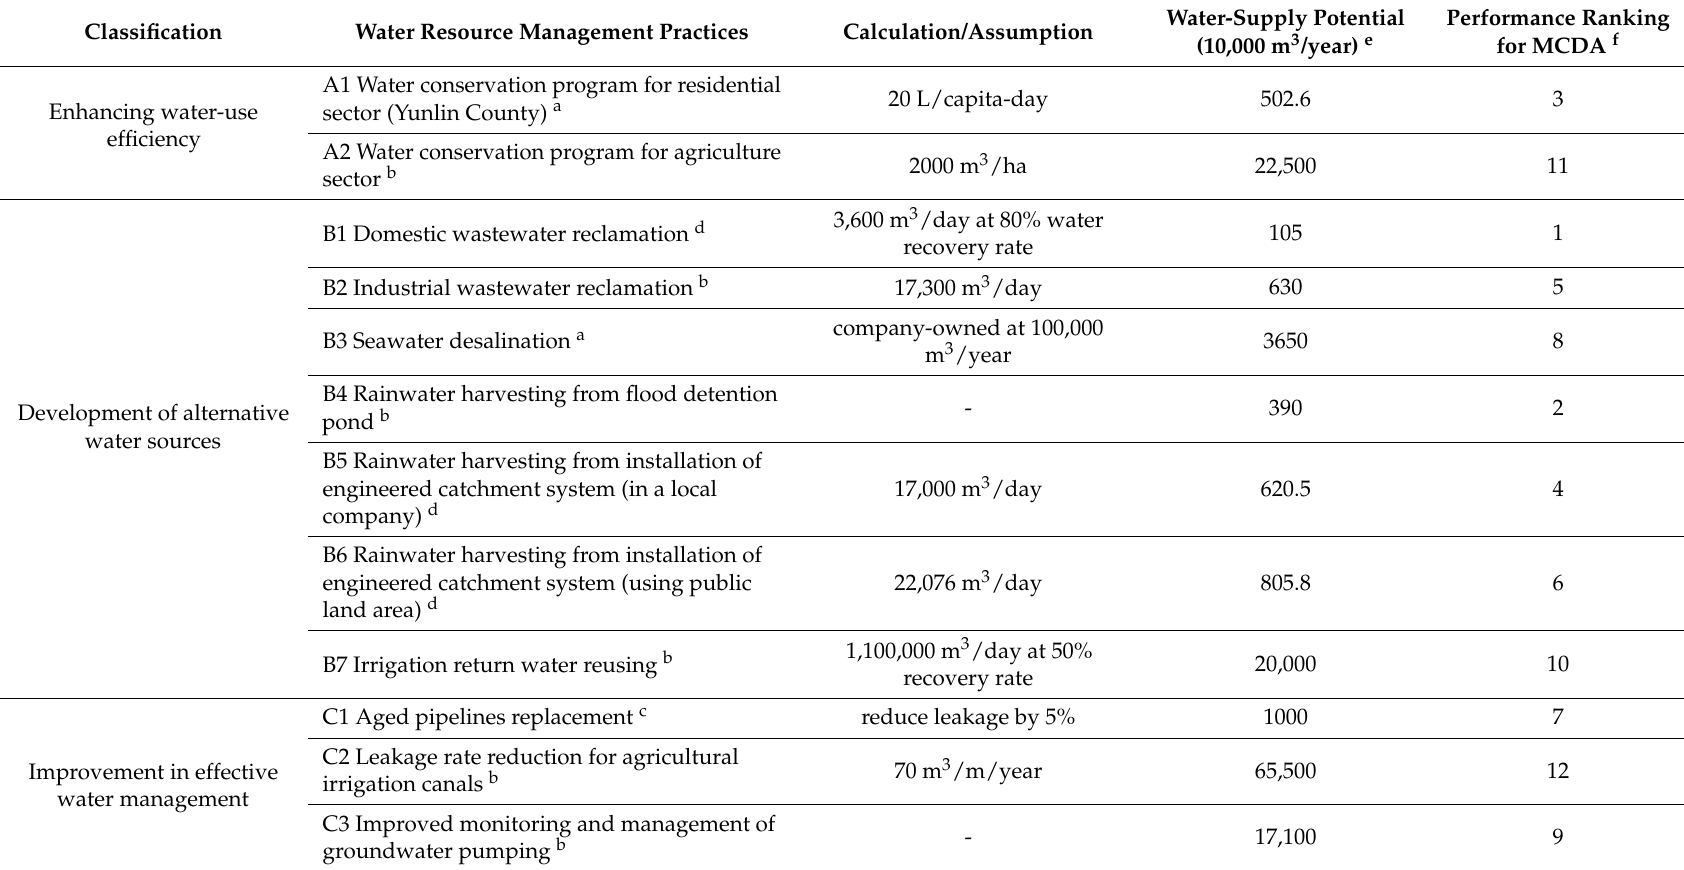
Table 5. Performance of water-supply potential and assigned rating value for the proposed